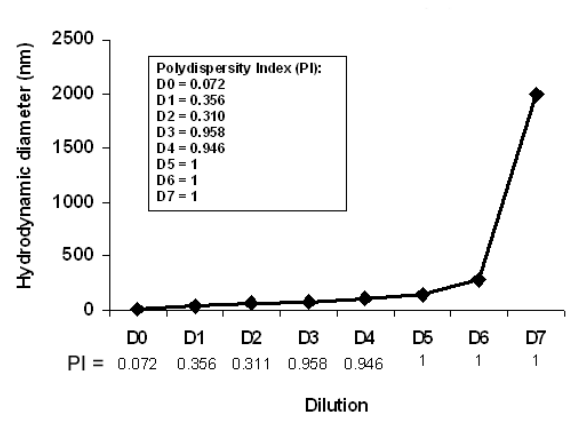
Figure 11. Evolution of the average particle size of the DPPC/DHPC bicelles with q = 3.5 by the effect of dilution as measured by DLS. The polydispersity indices are shown in the